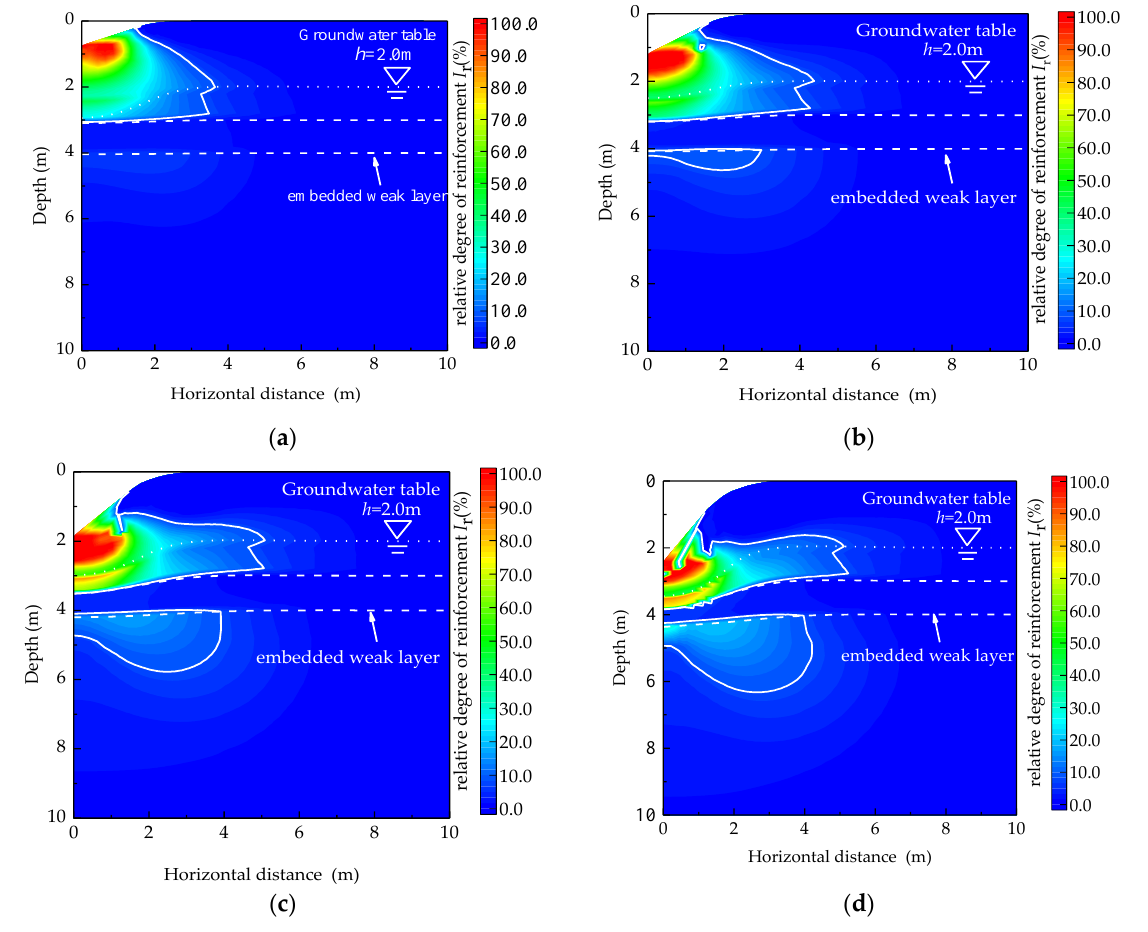
Figure 16. Distributions of I r of embedded weak layer for different tamping energy. ( a ) 1000 kN·m;